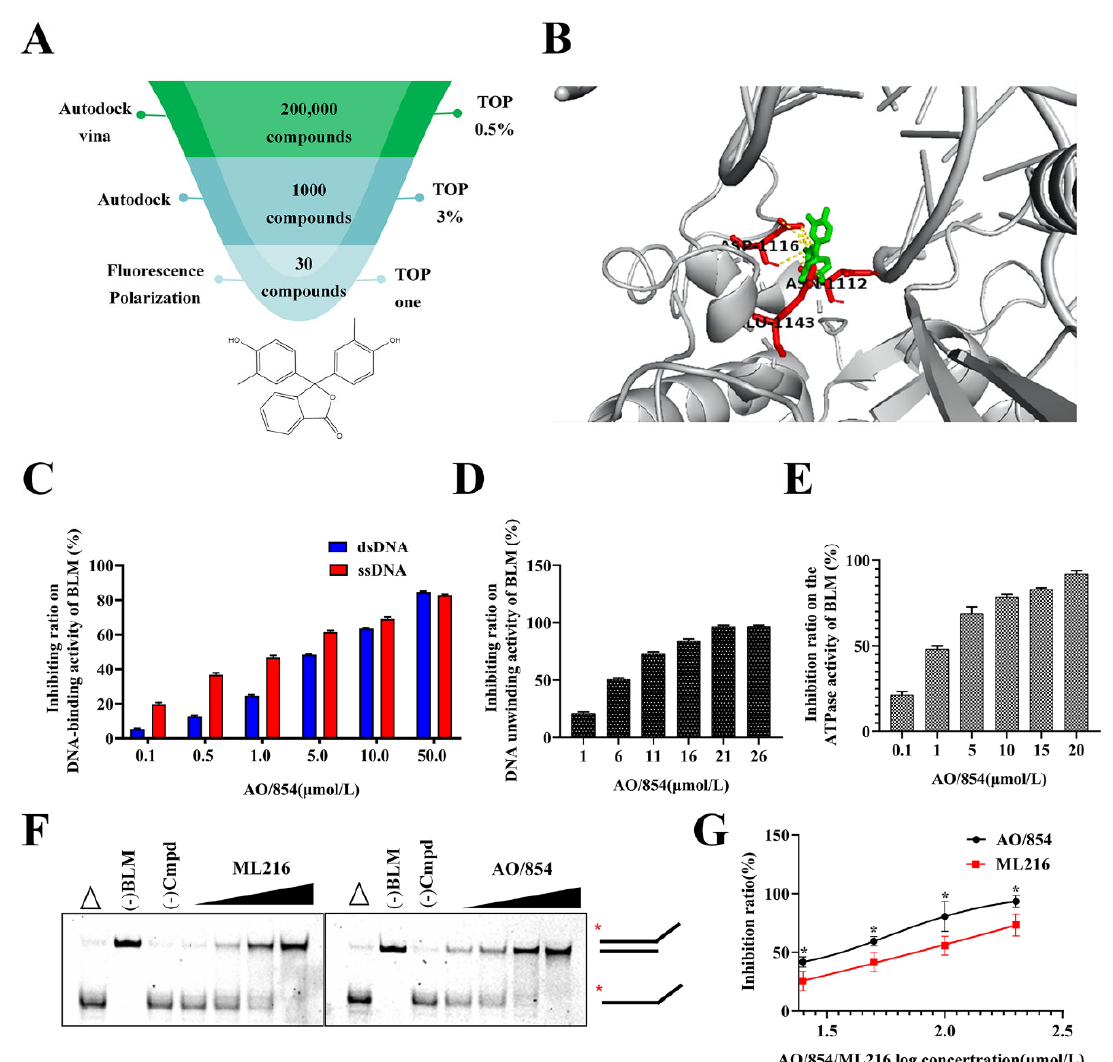
(Figure S3), selected a fluorescein-labeled dsDNA as a substrate, and used a fluorescence polarization assay to determine if the promising compounds disrupted the binding between BLM and DNA. It was found that the compound with ID number AO/854/43447428, referred to as AO/854, can significantly reduce the fluorescence polarization value of the BLM 642 − 1290 and dsDNA complex (Table S2).